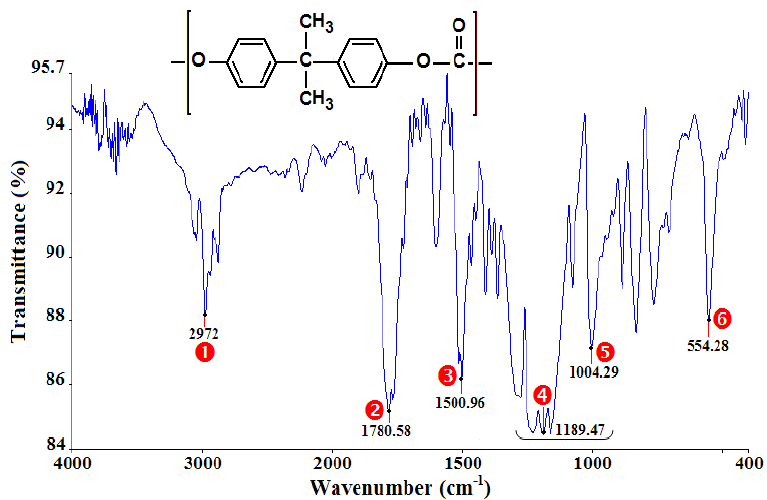
Figure 3. Infrared spectra of PC.